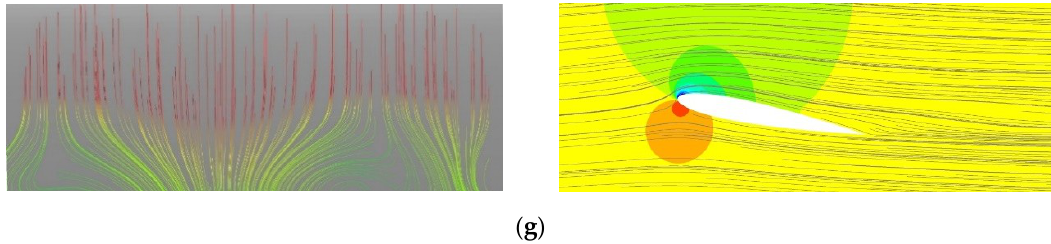
Figure 10. Stall cells on the aerofoil surface. Maximum AoA = 21°, f = 0.025. ( a ) AoA = 18.01° ↓ ; ( b ) AoA = 17.38° ↓ ; ( c ) AoA = 16.69° ↓ ; ( d ) AoA = 15.20° ↓ ; ( e ) AoA = 14.39° ↓ ; ( f ) AoA = 12.67° ↓ ; ( g ) AoA = 10.86° ↓ .